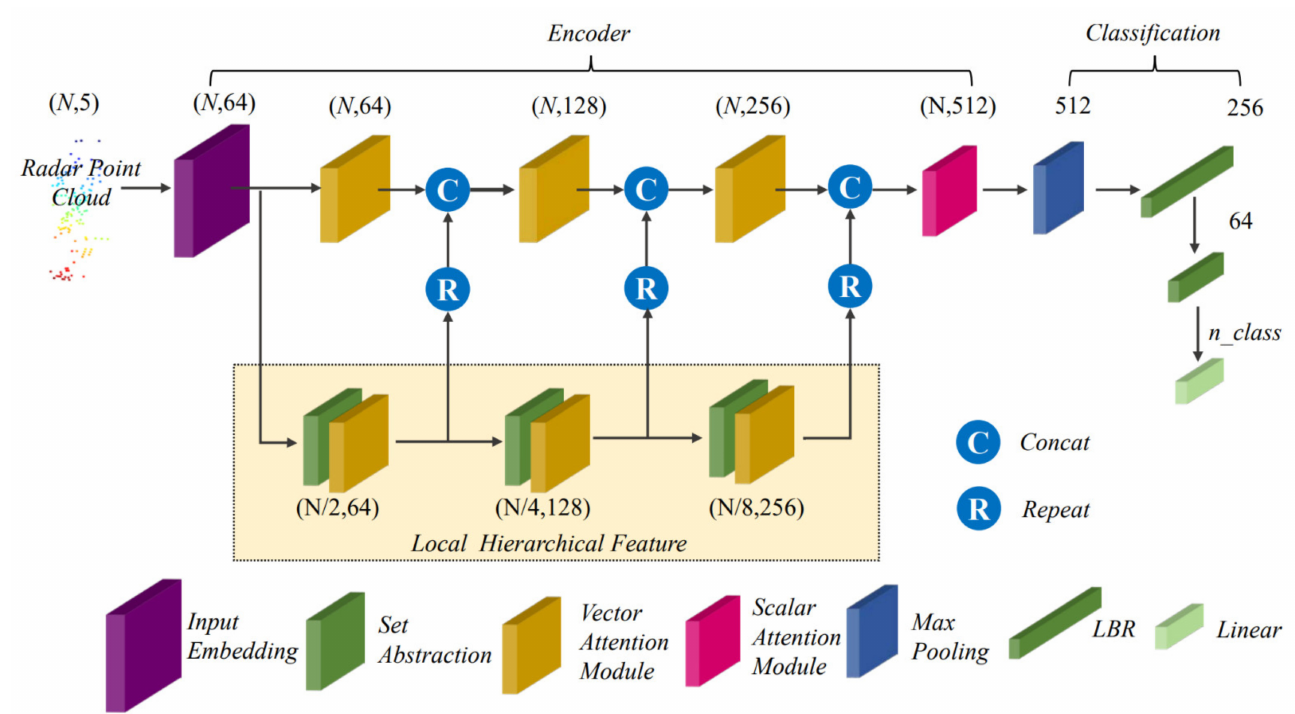
Figure 1. Radar Transformer architecture. The encoder mainly consists of an input embedding module, set abstraction module, vector attention module and scalar attention module, where the local hierarchical features are deeply fused with global features. The decoder consists of multiple linear layers. LBR combines linear, BatchNorm and ReLU layers. The numbers represent the feature dimensions after this